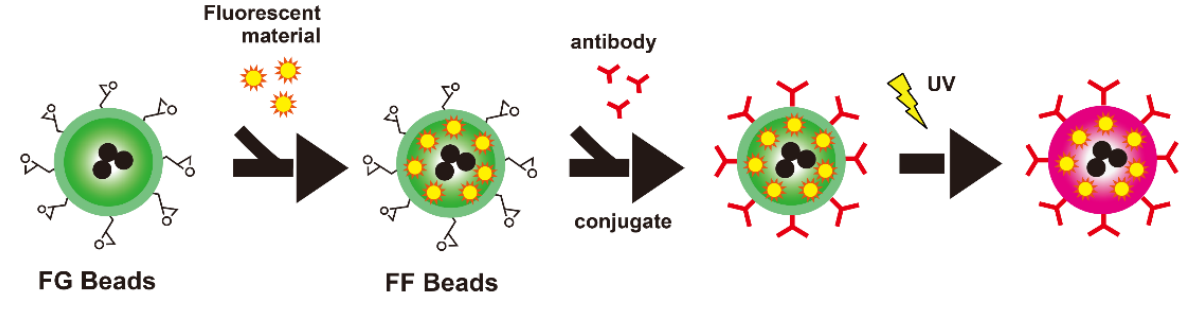
Figure 4. Scheme of FF beads. FF beads were prepared by encapsulating fluorescent materials in FG beads. Antibodies were immobilized on FF beads. FF beads emit fluorescence upon exposure to UV excitation. Modified from Kabe et al.